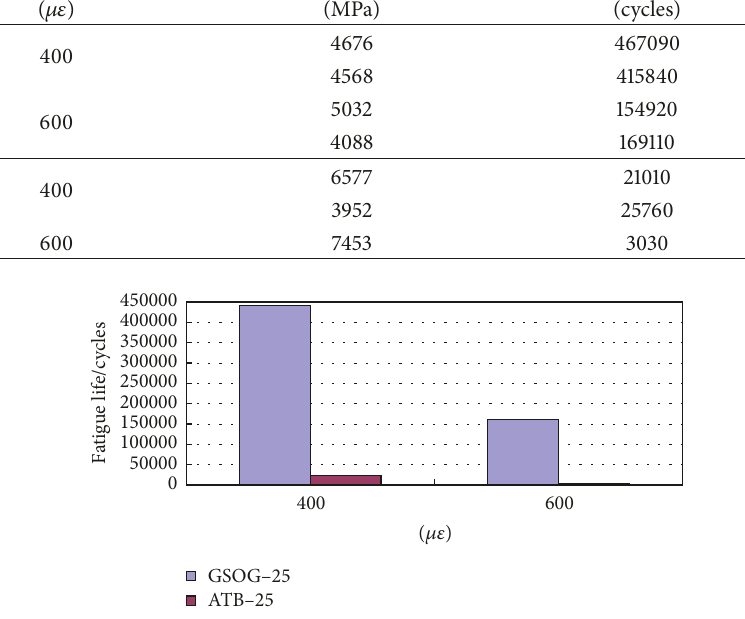
Figure 1: Comparison of fatigue lives of the two